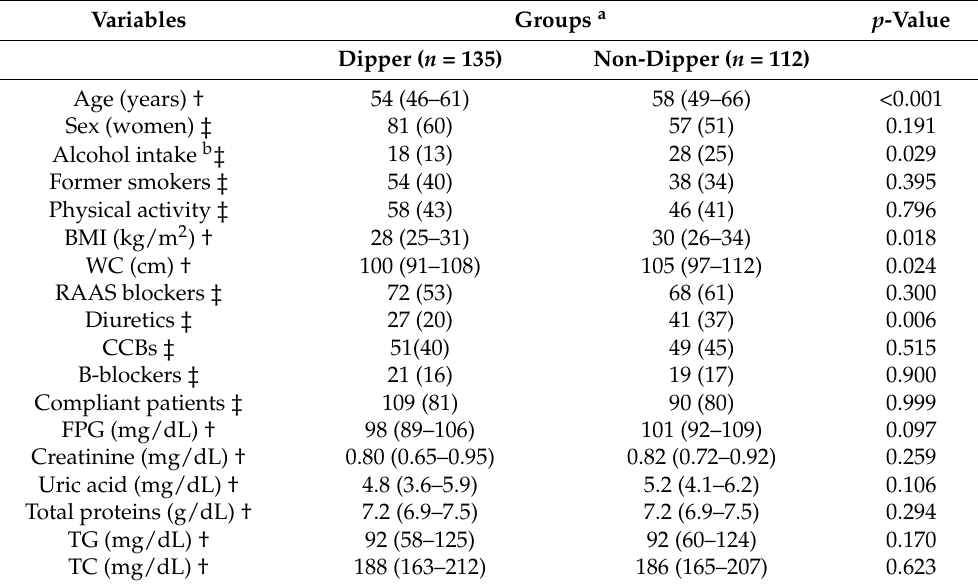
Table 1. Clinical and laboratory features. Comparisons between the groups of interest attending to the blood pressure circadian profile.